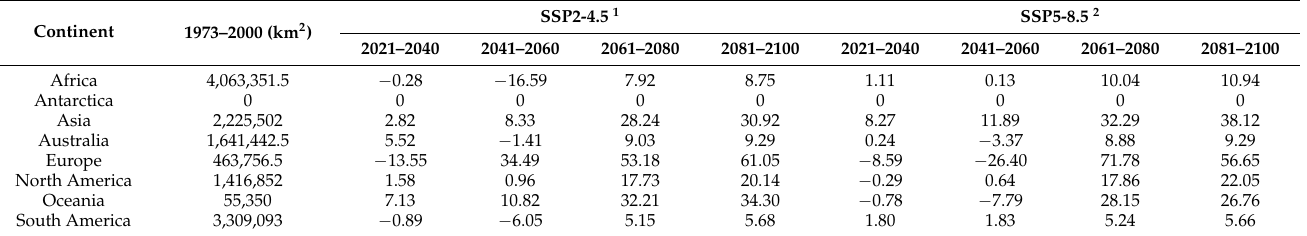
Figure 3. Potential distribution of P . hysterophorus around the world and in South Korea under the current climate (1973 – 2000) and future climate scenarios (SSP5-8.5; 2021 – 2040, 2041 – 2060, 2061 – 2080, and 2081 – 2100). Green and red colors indicate the unsuitable and suitable habitats for P. hysterophorus , respectively. Table 3. Change in the suitable habitat (%) of P. hysterophorus in different continents in future compared to the current climatic condition (1973–2000).